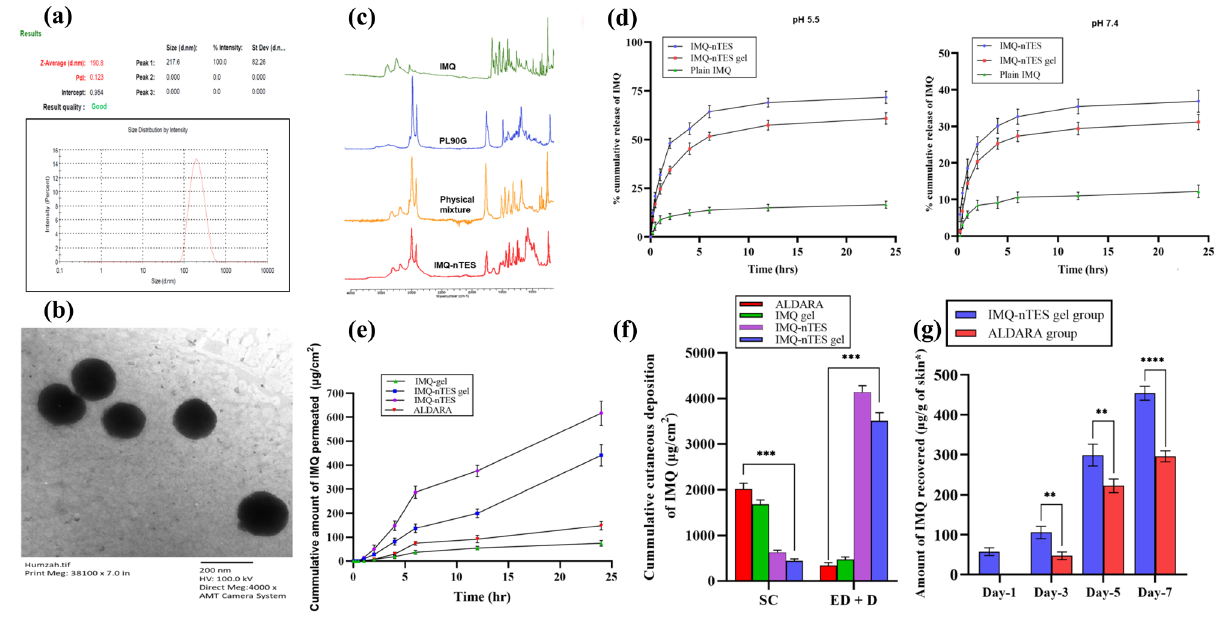
Figure 4. ( a ) Vesicle size and PDI of optimized IMQ-nTES. ( b ) TEM micrograph of optimized IMQ-nTES. ( c ) FTIR of IMQ-nTES and its component. ( d ) In vitro IMQ release pattern at pH 5.5 and pH 7.4. ( e ) Ex vivo skin permeation of IMQ. ( f ) Cumulative amount of IMQ deposition in rat skin. ( g ) IMQ amount recovered from stripped skin of disected BALB/c mice from IMQ-nTES gel and ALDARA group. Data is presented as mean ± S.D, n = 3; *p < 0.05, **p < 0.01, ***p < 0.001, ns p > 0.05. SC stratum corneum, ED epidermis, D